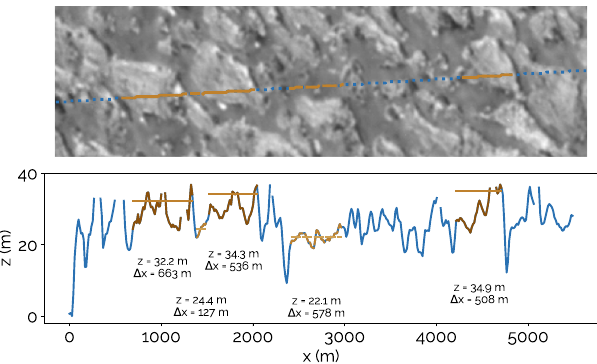
Fig. 6 Estimated heights of the Chaac Patera ridges from photoclinometry. The top panel is from the same source image from near Chaac Patera that is shown in Fig. 3c, but is here unprojected. The line is the trace of a sun ray, with solid brown regions corresponding to ridge pixels and dashed brown regions corresponding to inter-ridge pixels, both of which are used to estimate heights. The lower panel shows the heights derived with photoclinometry corresponding to locations in the upper panel. The horizontal lines show the ridge and inter-ridge heights that we extract (see Methods), which are displayed as the z values. The widths of each region are indicated as Δ x